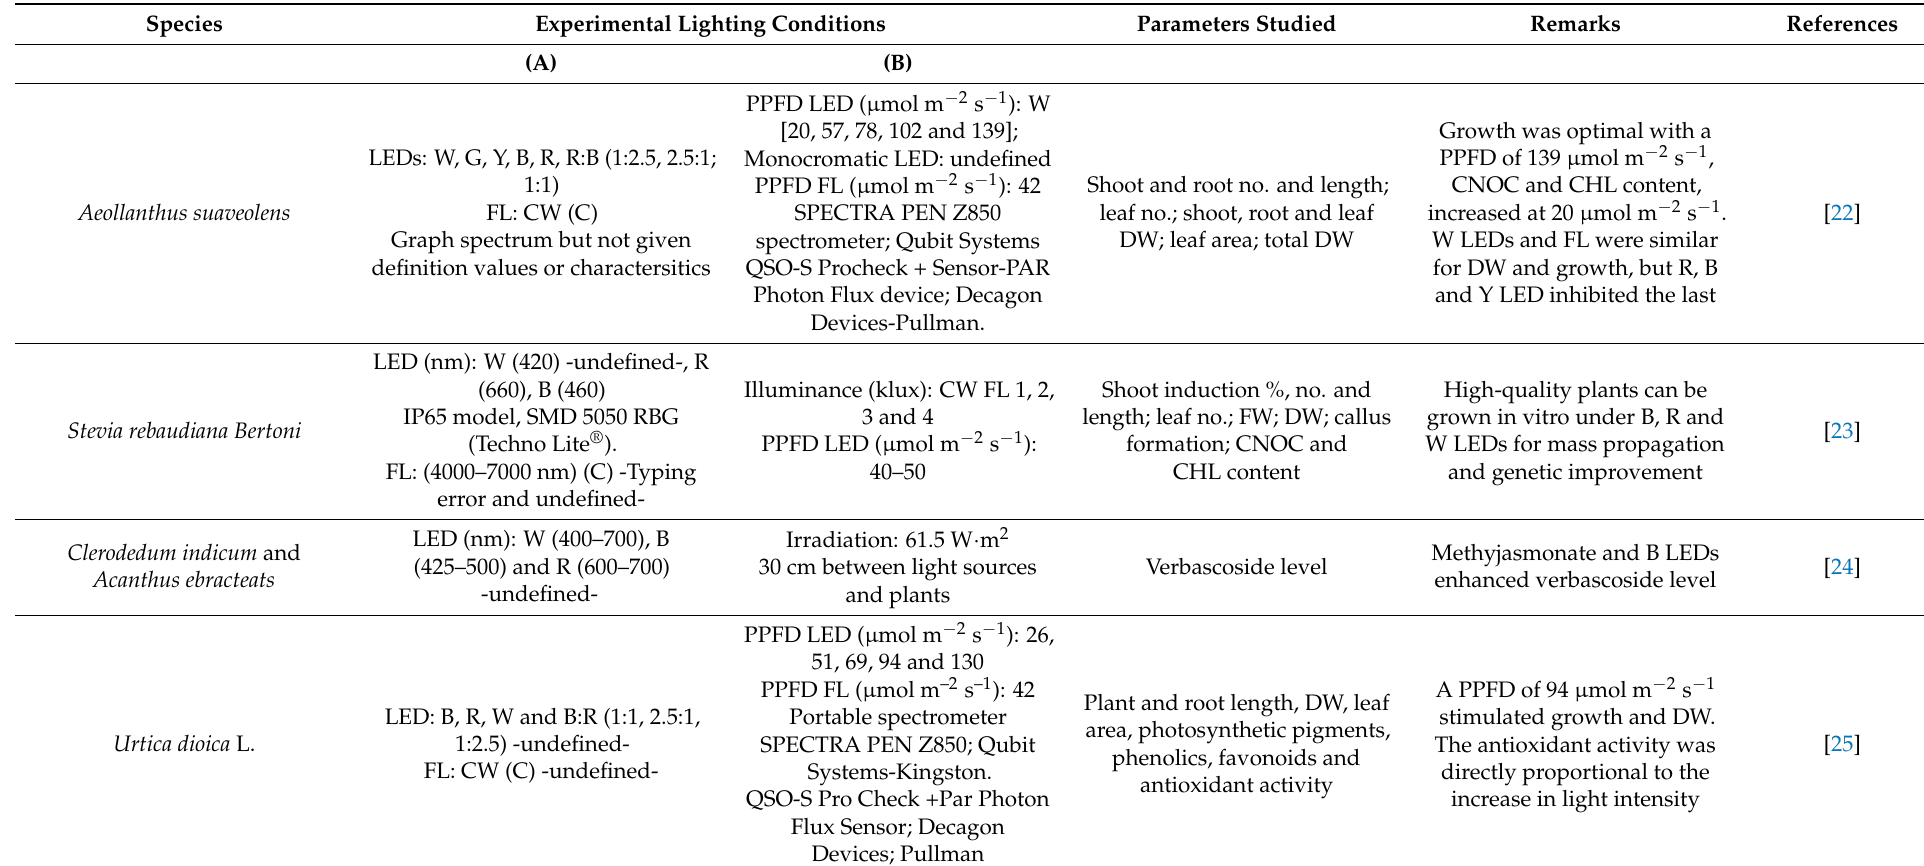
Table 4. Experimental LED lighting conditions on in vitro plant tissue culture. (A): Lamps, spectrum. (B): Radiation, measurement equipment, laying distance. Species Experimental Lighting Conditions Parameters